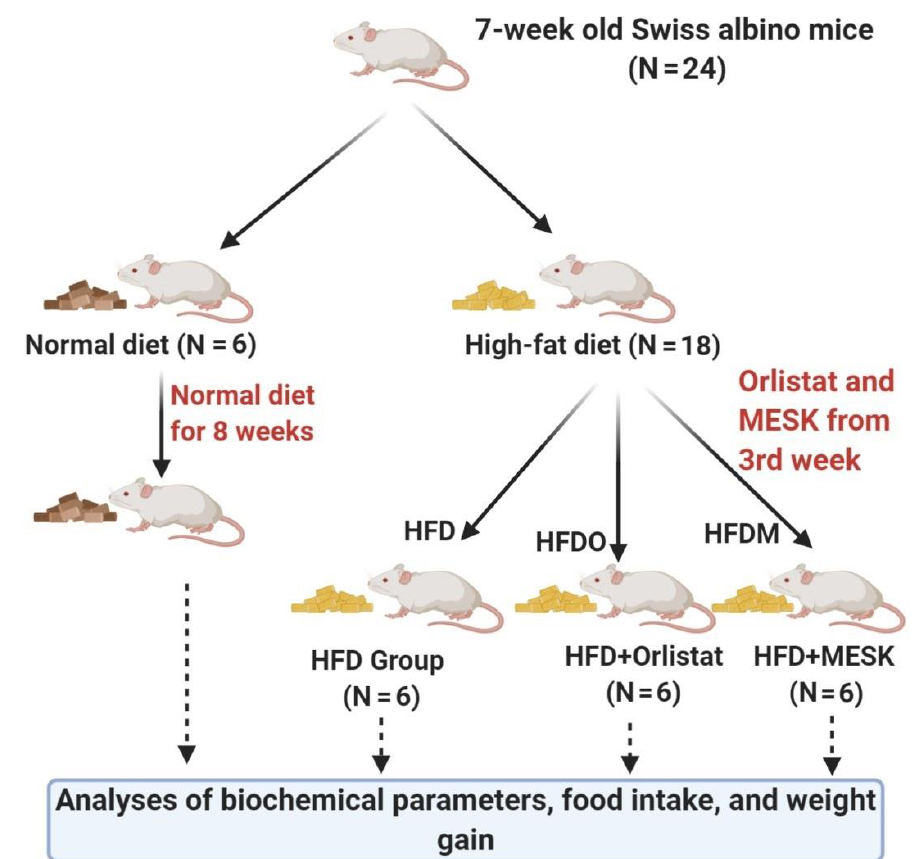
Figure 2. Flow chart representing the study design. The mice were divided into 4 groups after the acclimatization period. The normal diet (ND) mice received a standard chow diet during the complete 8-week study period. Similarly, the HFD group received a high-fat diet during the complete 8-week study period. However, the HFDO (HFD + Orlistat) and HFDM (HFD + Mangifera indica seed kernel (MESK)) groups were given respective treatments from the third week onwards until the end of the study.